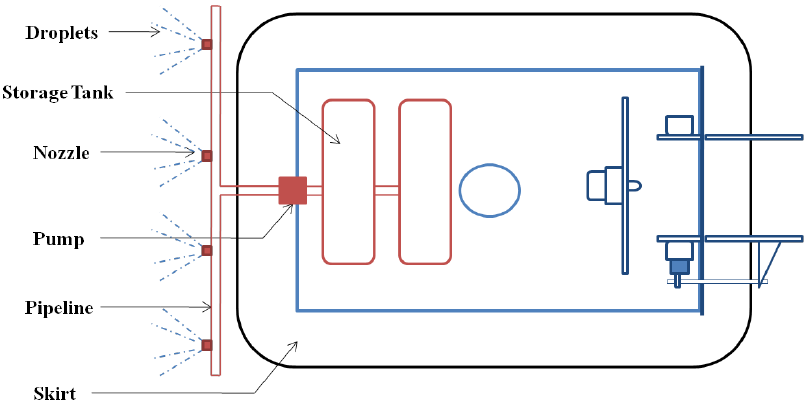
Figure 19. Hovercraft with sprayer